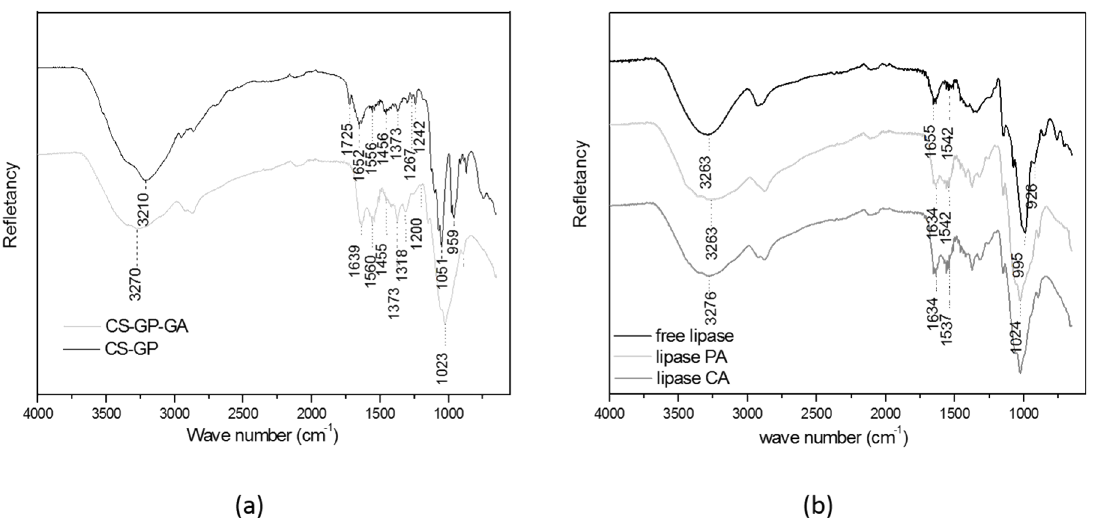
Figure 3. (a) Fourier Transformed Infrared Specta of (black) chitosan-glycerol phosphate support, and (grey) chitosan-glycerol phosphate crosslinked with glutaraldehyde. (b) Fourier Transformed Infrared Specta of (black) free lipase, (light grey) system lipase immobilized by physical absorption, and (dark grey) system lipase immobilized by covalent